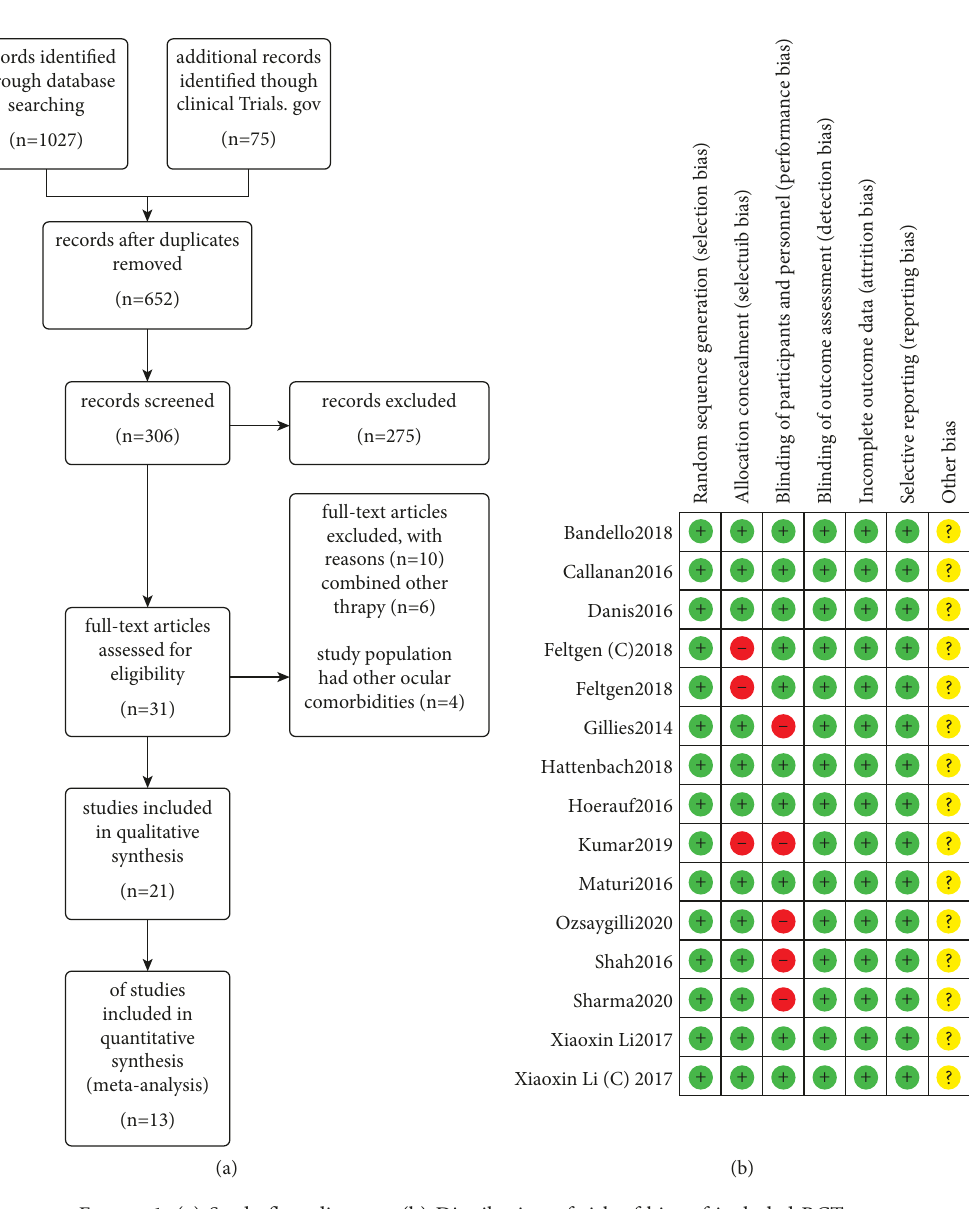
Figure 1: (a) Study flow diagram. (b) Distribution of risk of bias of included